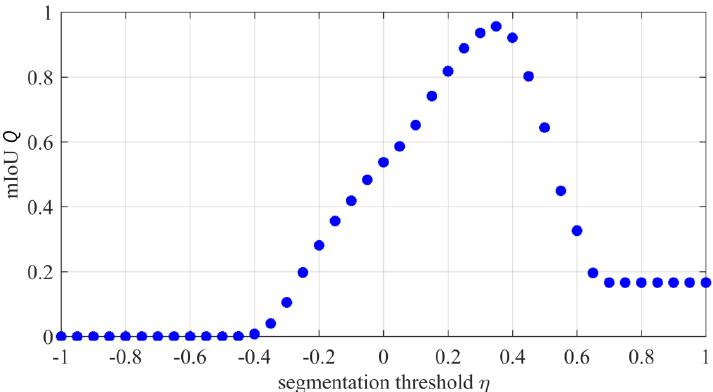
Figure 10. The impact of different segmentation thresholds η on sea-land segmentation. mIoU, mean intersection-over-union.